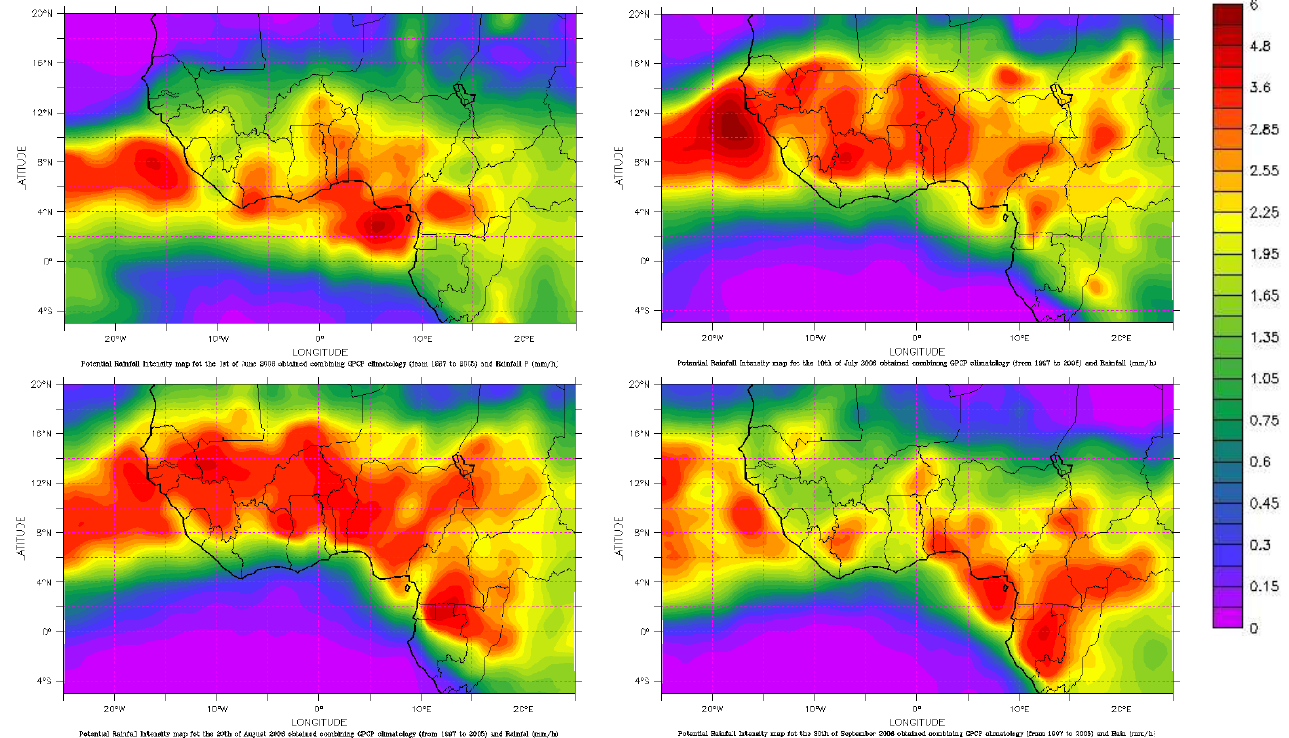
Figure 11. EPSAT-SG Rainfall Potential Intensity computed with a 8-year climatology instead of actual data.